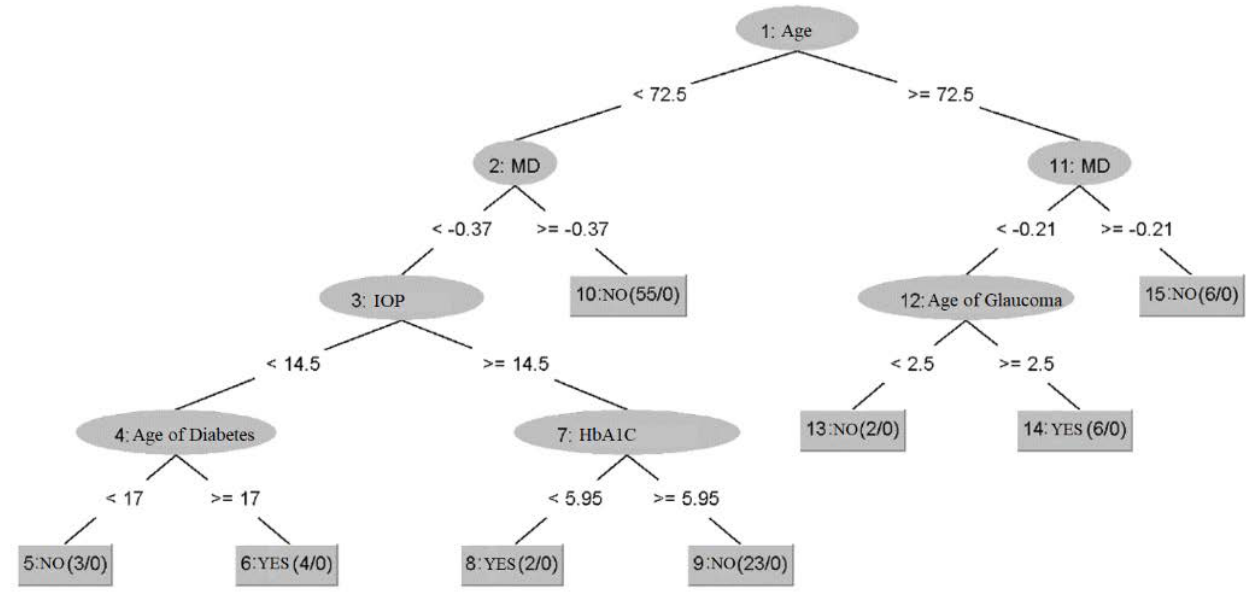
Figure 7. Results of the use of Random tree algorithm to predict diabetic